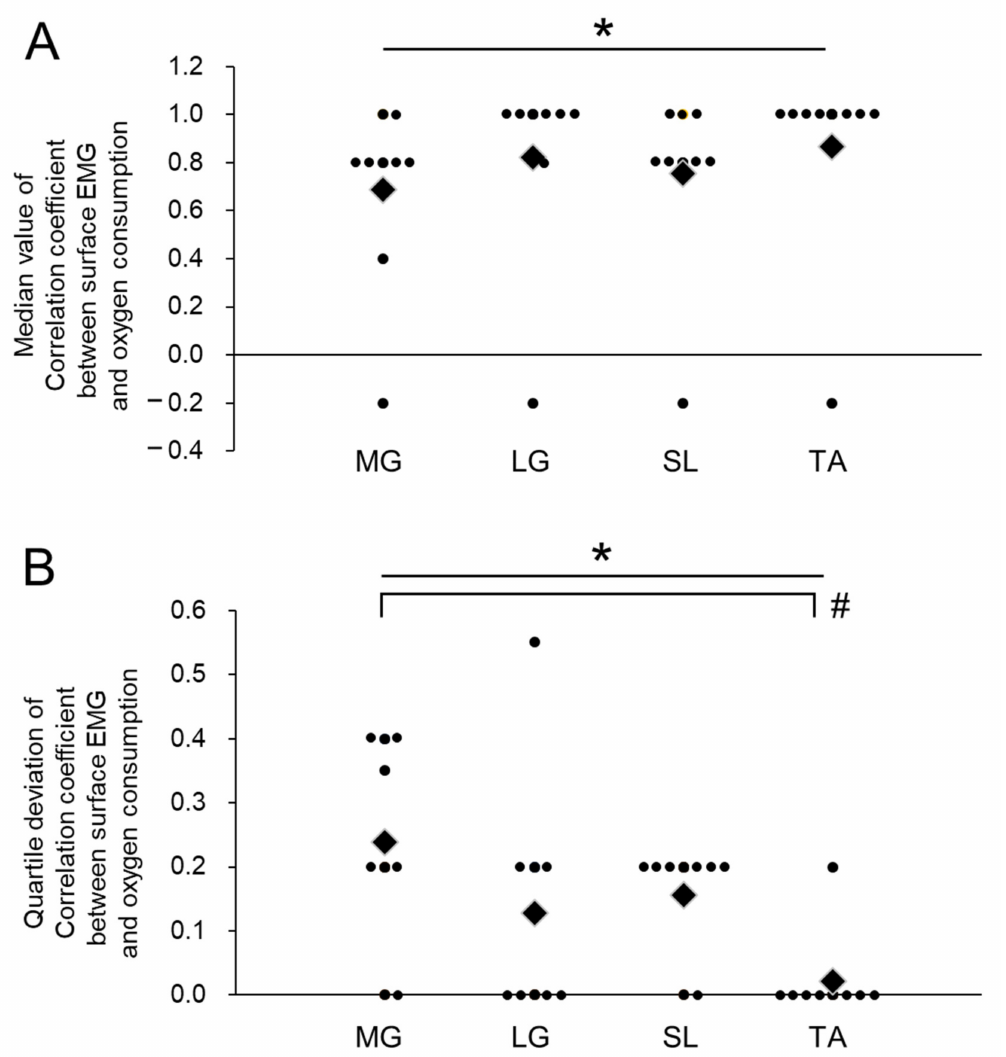
Figure 3. Median values ( A ) and quartile deviation ( B ) of correlation coefficients in electrode grids for individual muscles. Diamonds and circles indicate the mean values and individual participants, respectively. * p < 0.05, significant effect of muscle, # p < 0.0083, significant difference between